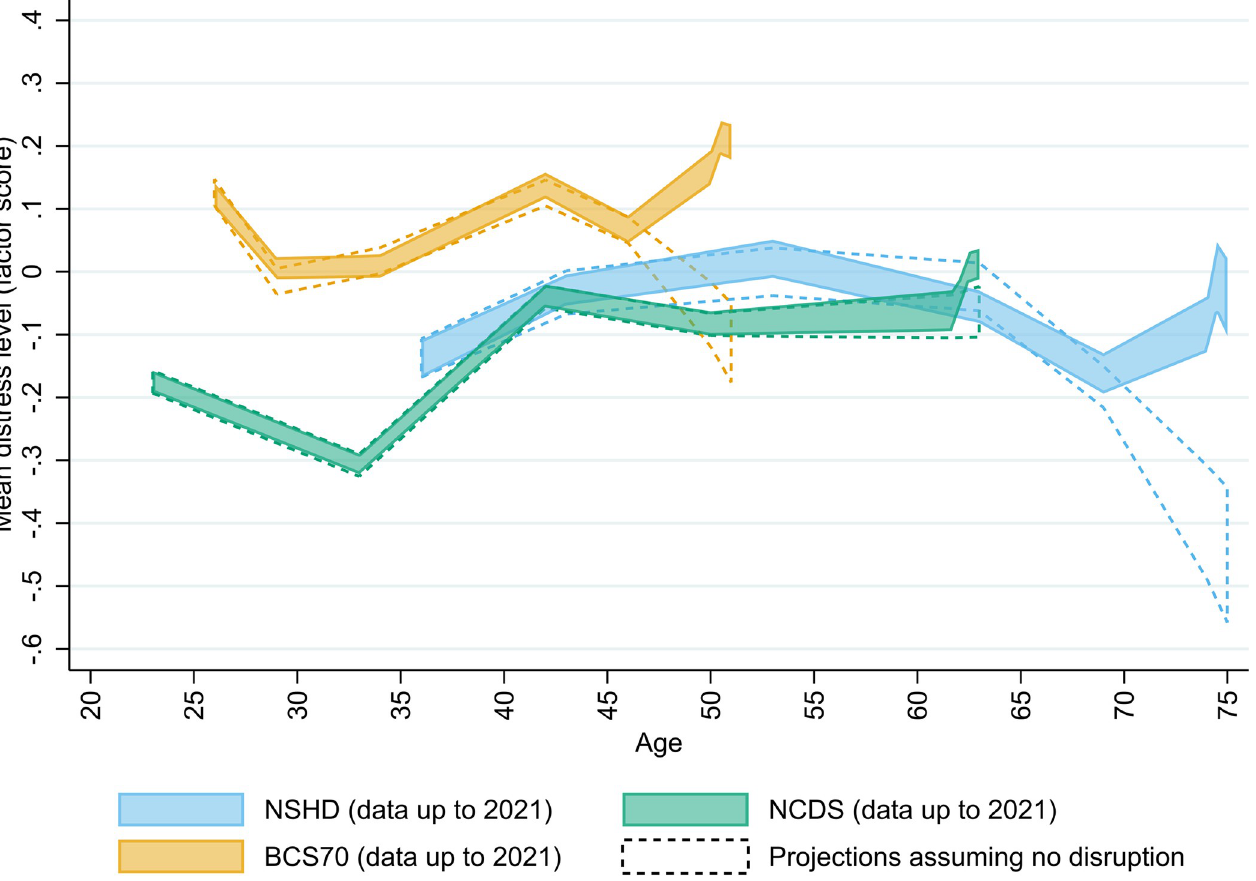
Fig 3. Projections of mean psychological distress cross-cohort factor scores assuming no disruption. Unadjusted results. All areas correspond to 95% confidence intervals. BCS70: 1970 British Cohort Study; NCDS: 1958 National Child and Development Study; NSHD: 1946 National Survey of Health and Development. Projections assuming no disruption are based on data up to 2015 (NSHD), 2020 (NCDS), and 2016 (BCS70).